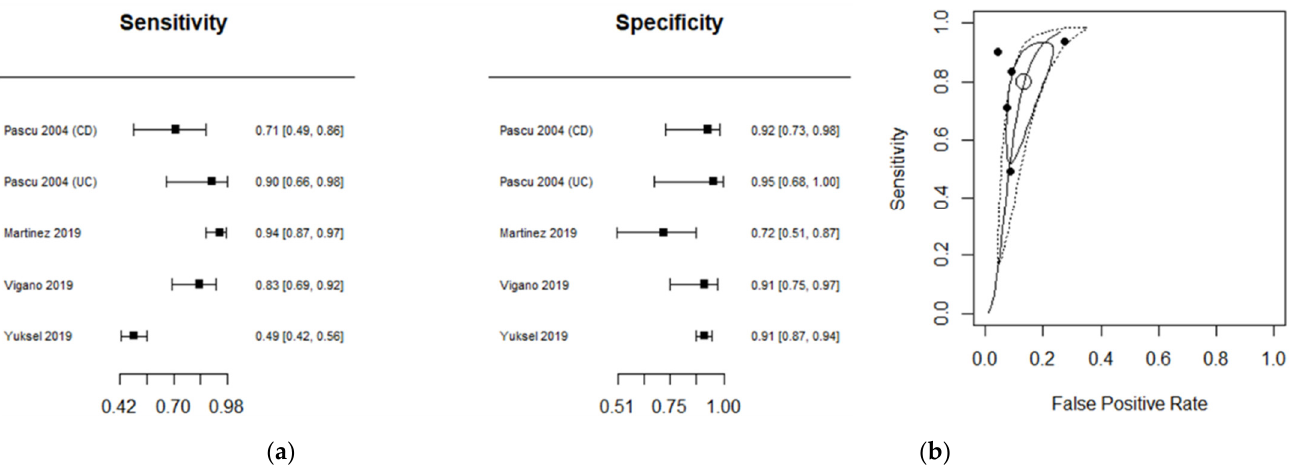
Figure 4. ( a ) Forest plot and ( b ) the summary receiver operating characteristic (ROC) curve illustrating the summary operating point for the diagnostic performance of US.